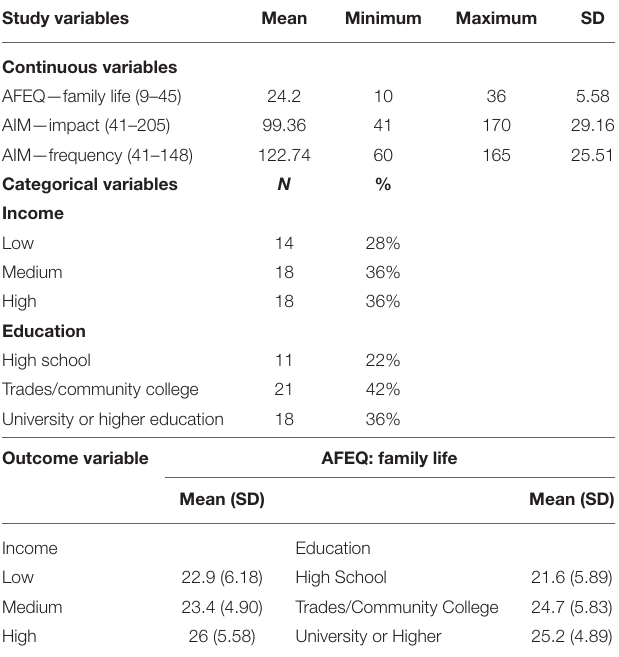
TABLE 1 | Sample descriptive statistics.